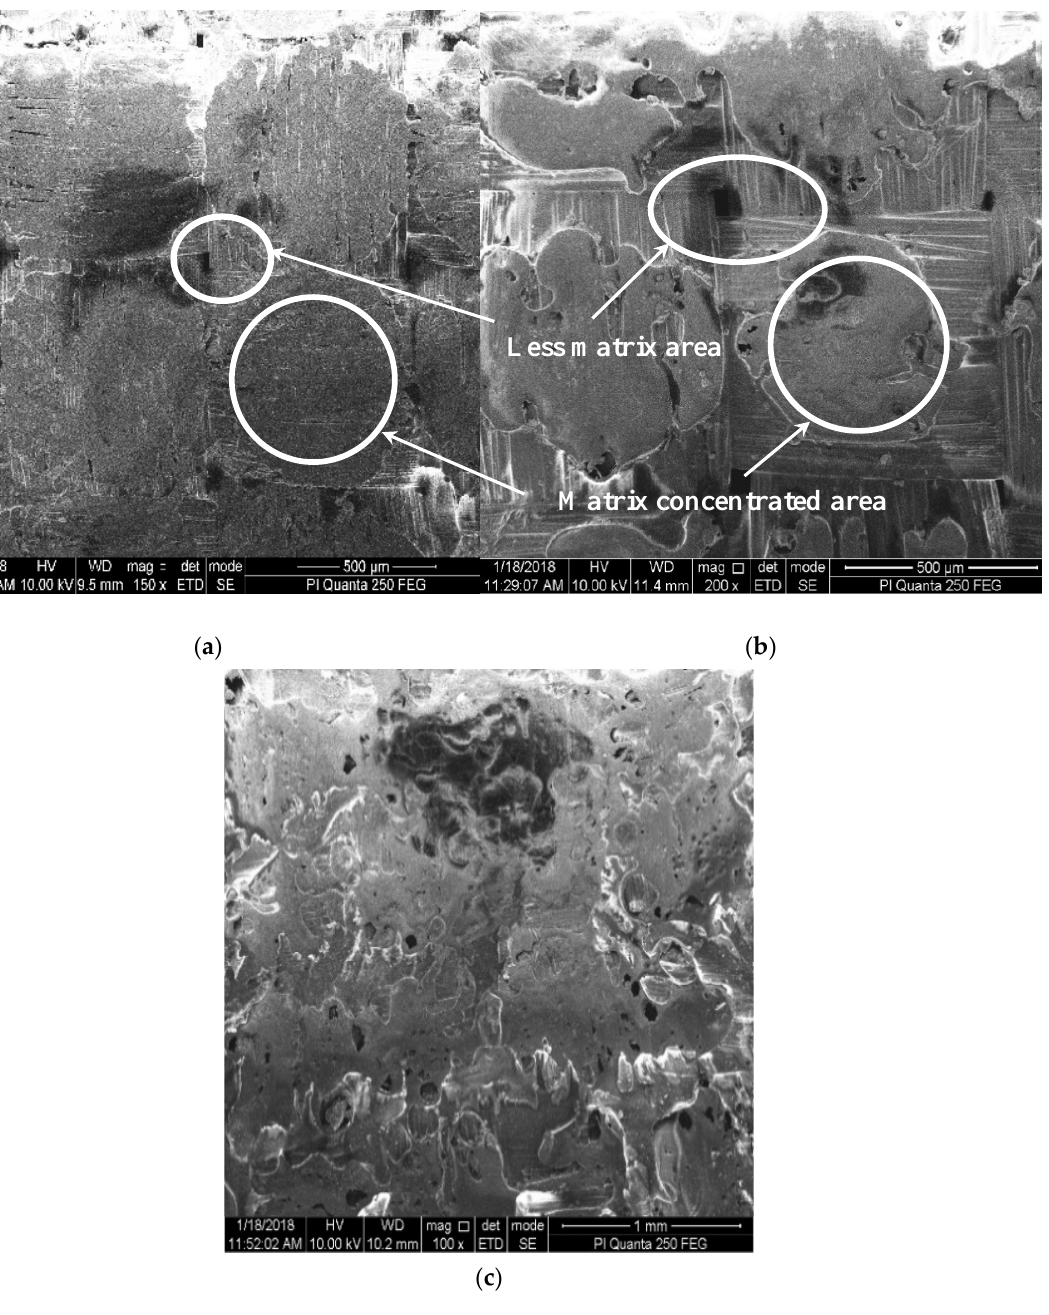
Figure 3. Texture of prepared composite sheets: ( a ) Control, ( b ) 1% Al 2 O 3 , ( c ) 1% SiC.